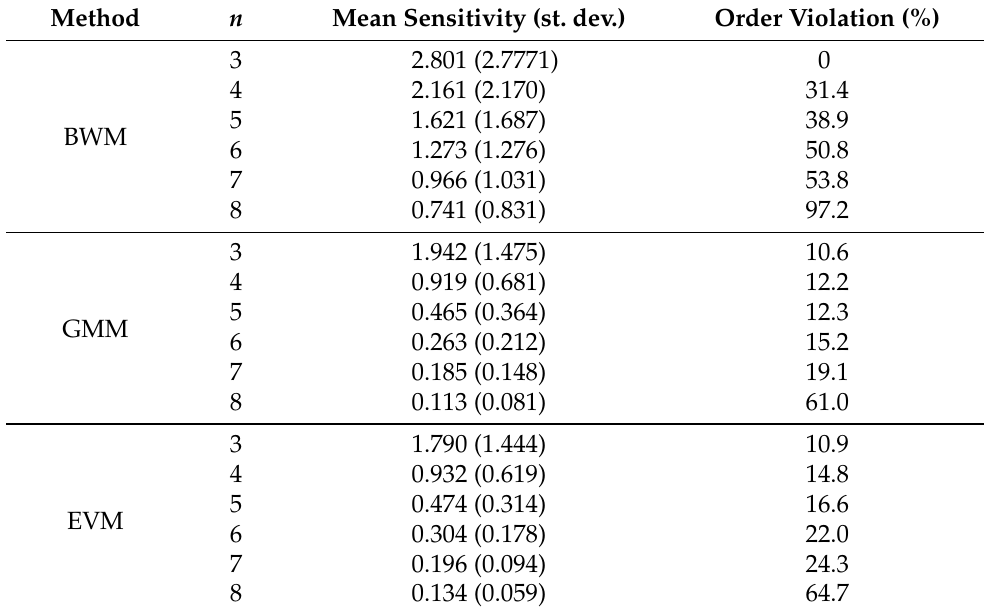
Simulation results: mean sensitivity and average order violation occurrence (for each method separately). BWM: Best–Worst Method; GMM: Geometric Mean Method; EVM: Eigenvalue Method.